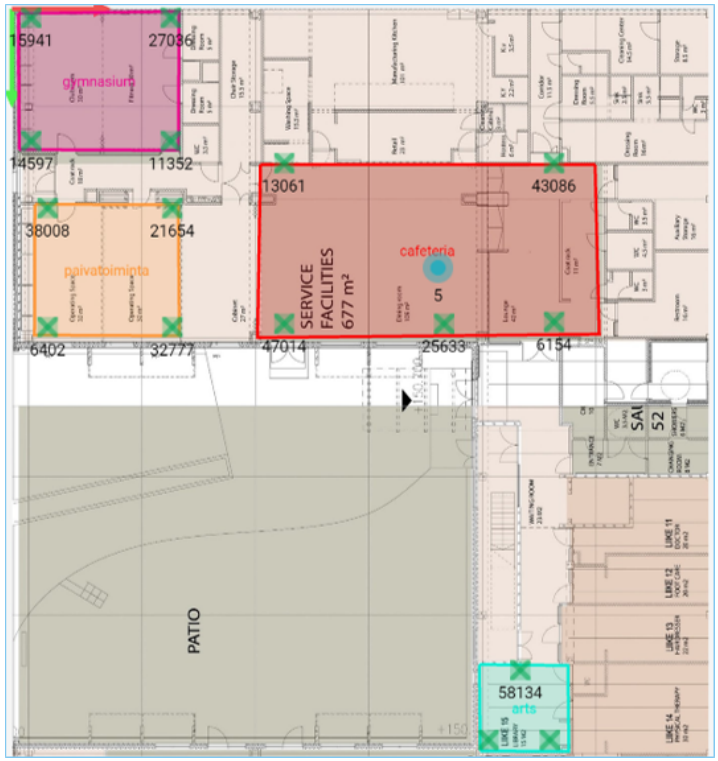
Figure 2. Virtual layout of the monitored